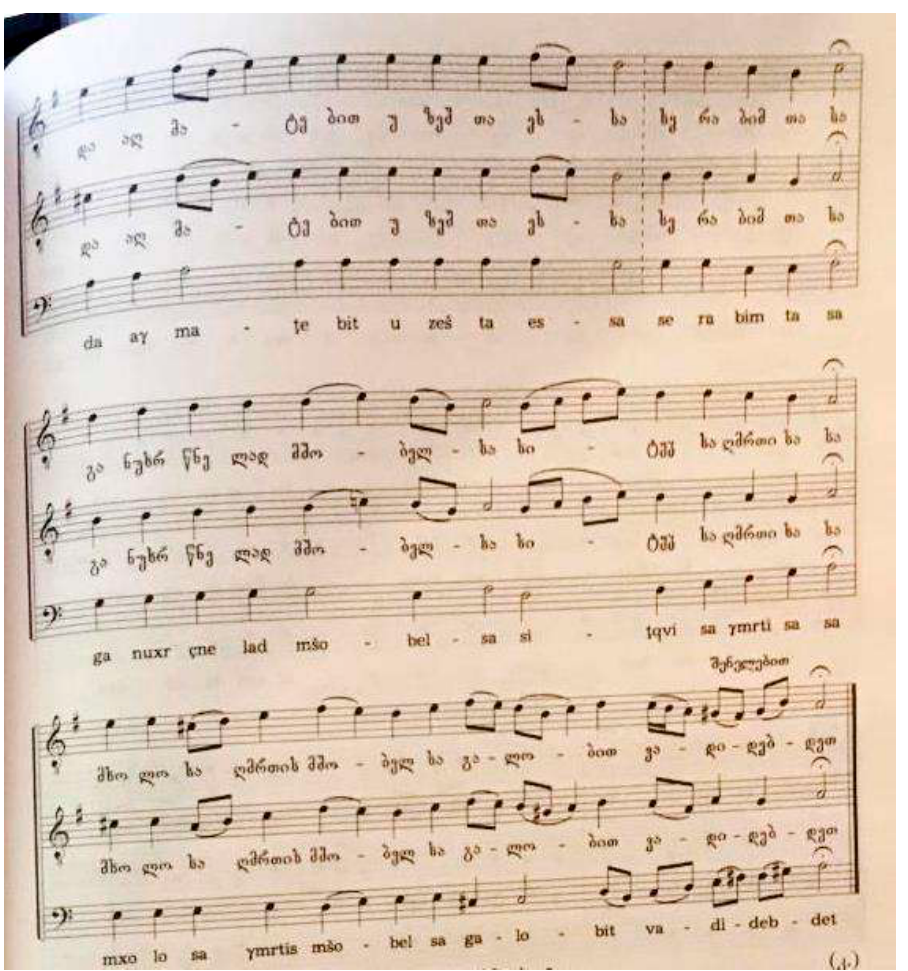
Figure 13. It Is Truly Meet; Gelati School (Erkvanidze 2004).